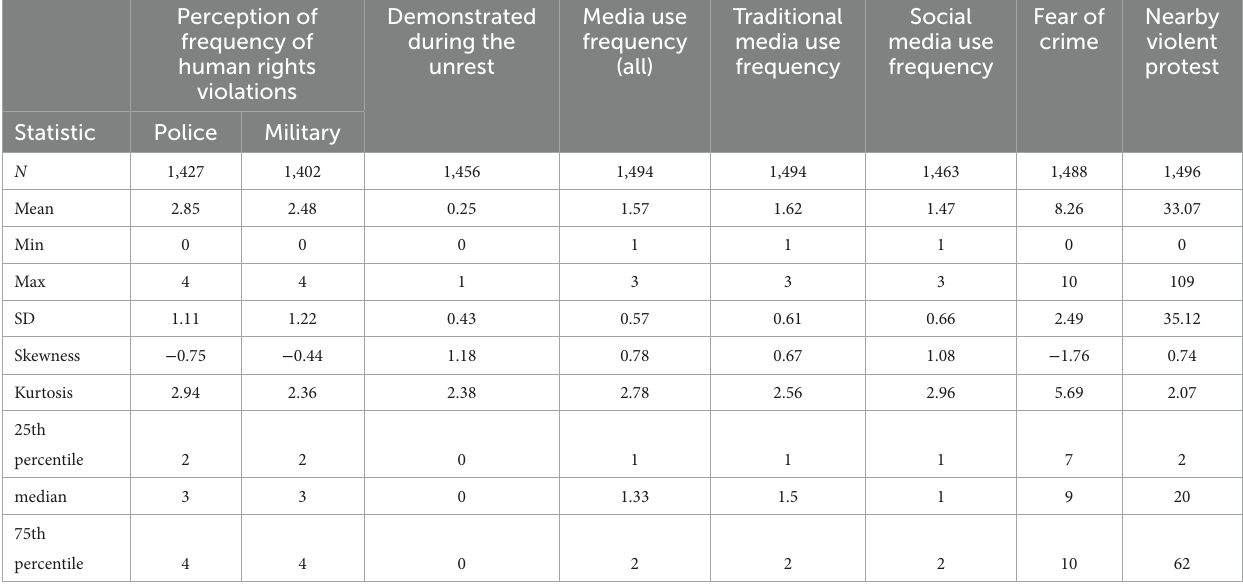
TABLE 1 Descriptive statistics of dependent and independent variables (CEP,